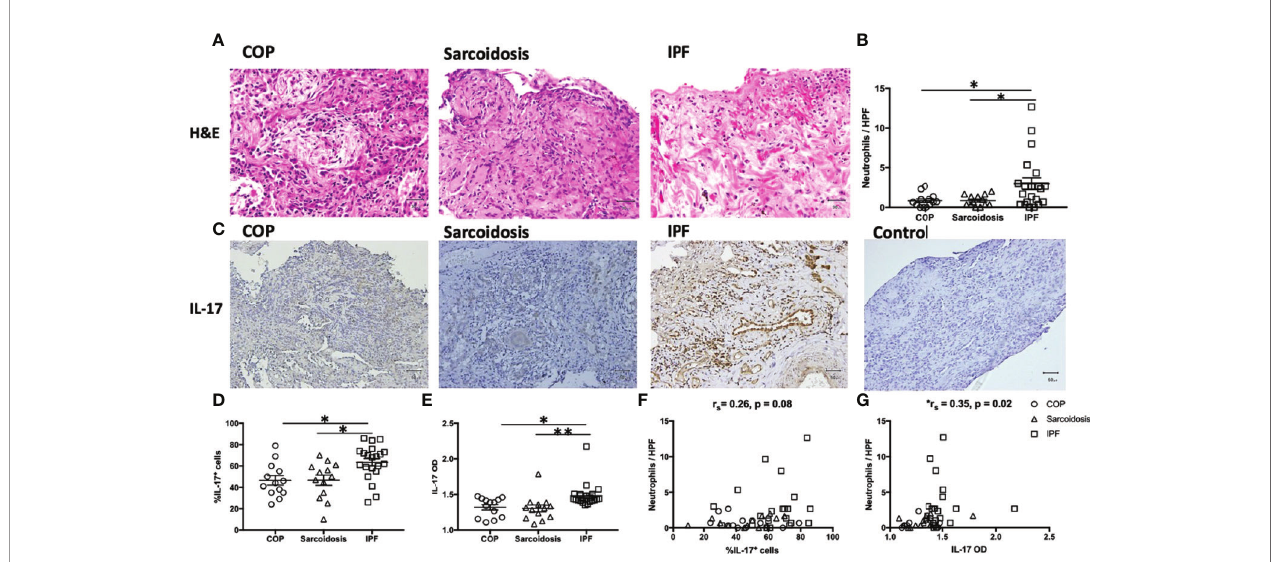
FIGURE 1 | Increased neutrophil in fi ltration and more IL-17 expression in IPF lungs. (A) Representative H&E images of lung specimens from subjects with COP, sarcoidosis and IPF. Magni fi cation ×400. (B) IPF lungs exhibited greater number of neutrophils. (C) Representative immunohistochemical image of lung specimens from subjects with COP, sarcoidosis and IPF. Magni fi cation ×200. (D, E) Immunohistochemical staining showed IPF lungs had a greater percentage of IL-17 + cells and higher IL-17 OD. (F, G) The expression of IL-17 is positively correlated with neutrophil counts in lung specimens. IL-17, interleukin-17; IPF, idiopathic pulmonary fi brosis; COP, cryptogenic organizing pneumonia; H&E, hematoxylin and eosin; HPF, high power fi elds (magni fi cation, x400); OD, opacity density score; *p < 0.05; **p < 0.01.